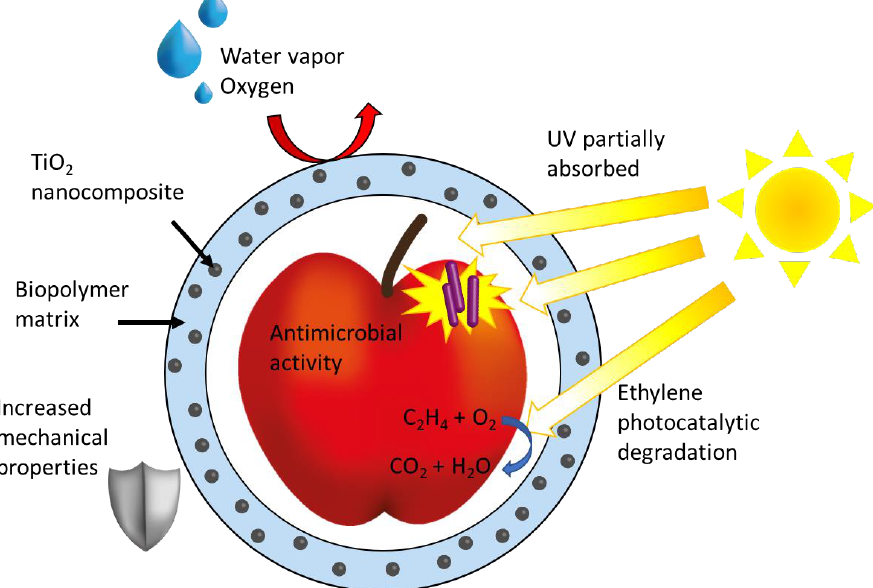
Figure 12. General scheme of TiO 2 NPs-based nanocomposite application for food packaging highlighting the advantages of TiO 2 in the coating as improved mechanical properties, water and oxygen repellence, UV shielding, and ethylene scavenger and antimicrobial activity.